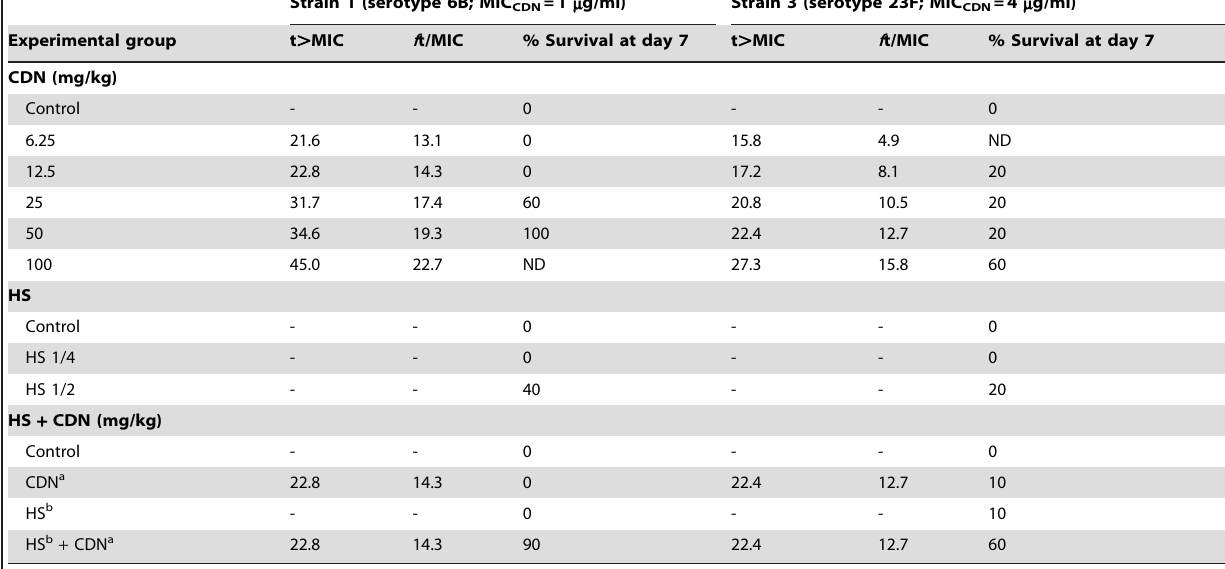
Table 1. Pharmacodymanics and efficacy against Strains 1 and 3.